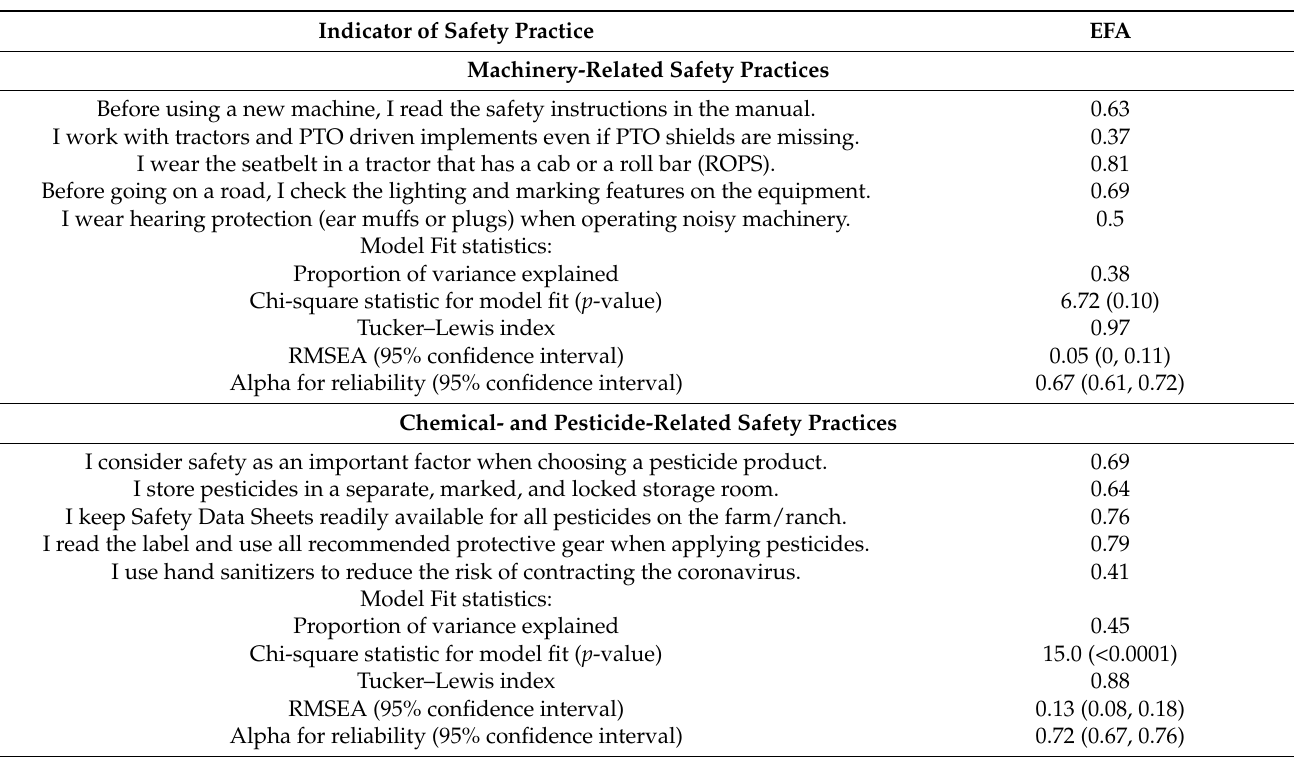
Table 3. Exploratory factor analysis (EFA) and model fit measures for each set of questions related to safety practices in farm and ranch operators in the central states region of the US,